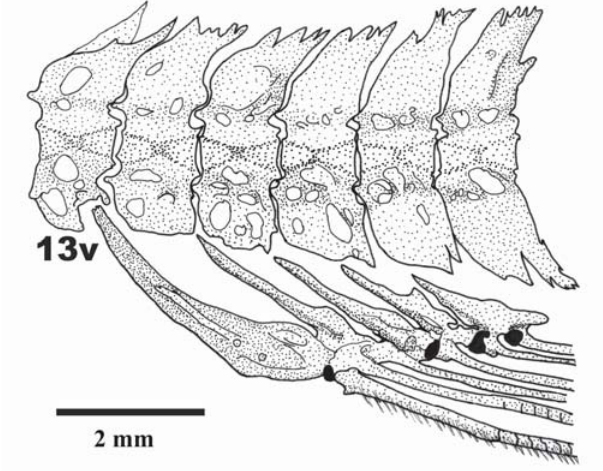
Fig. 3. Posterior abdominal vertebrae of Gymnotocinclus anosteos lacking bifid hemal spines. MCP 41726, paratype, male, 40.5 mm.